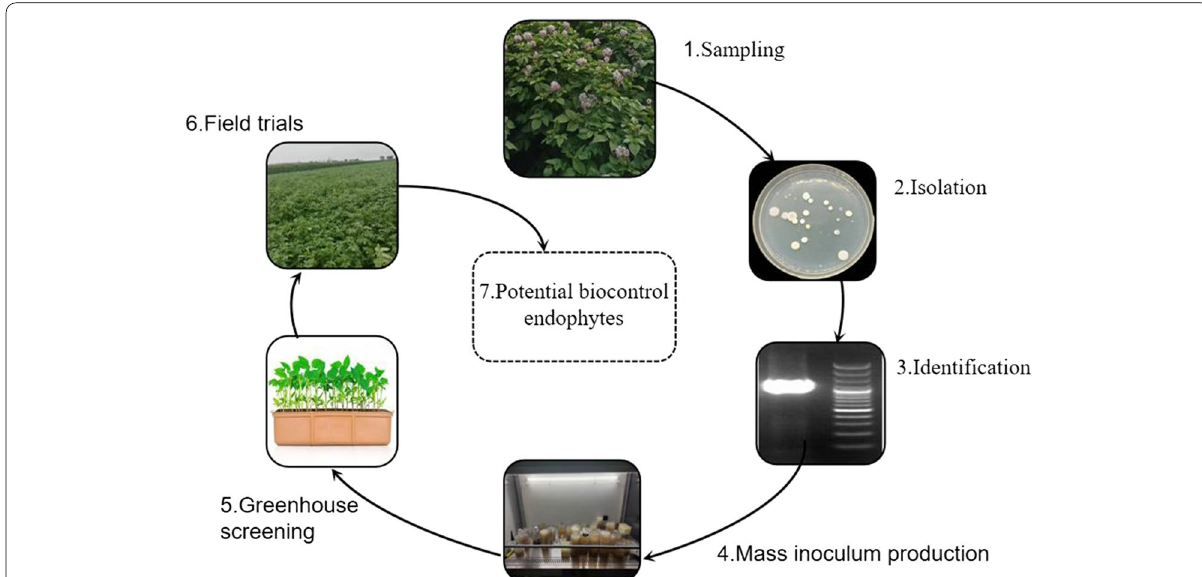
Fig. 1 Isolation and screening of endophytic bacteria for biocontrol. 1, sampling from thriving plants. 2, isolation from surface sterile tissues using artificial media. 3, molecular identification using ribosomal genes. 4, mass production tests. 5, screening test of endophytic bacteria to plants in greenhouse. 6, endophytic bacteria with growth-promoting effect were tested in the field. 7, the potential PGPR can enter the industrial